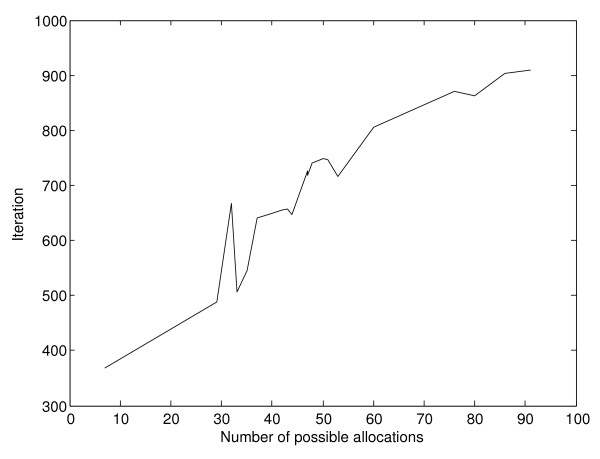
Mean convergence of module algorithm per experiment, according to search space size. Experiments are represented in an ordered fashion, from the one with least expressed multi-membership genes, and smallest search space to the one with most expressed multi-membership genes and largest search space.